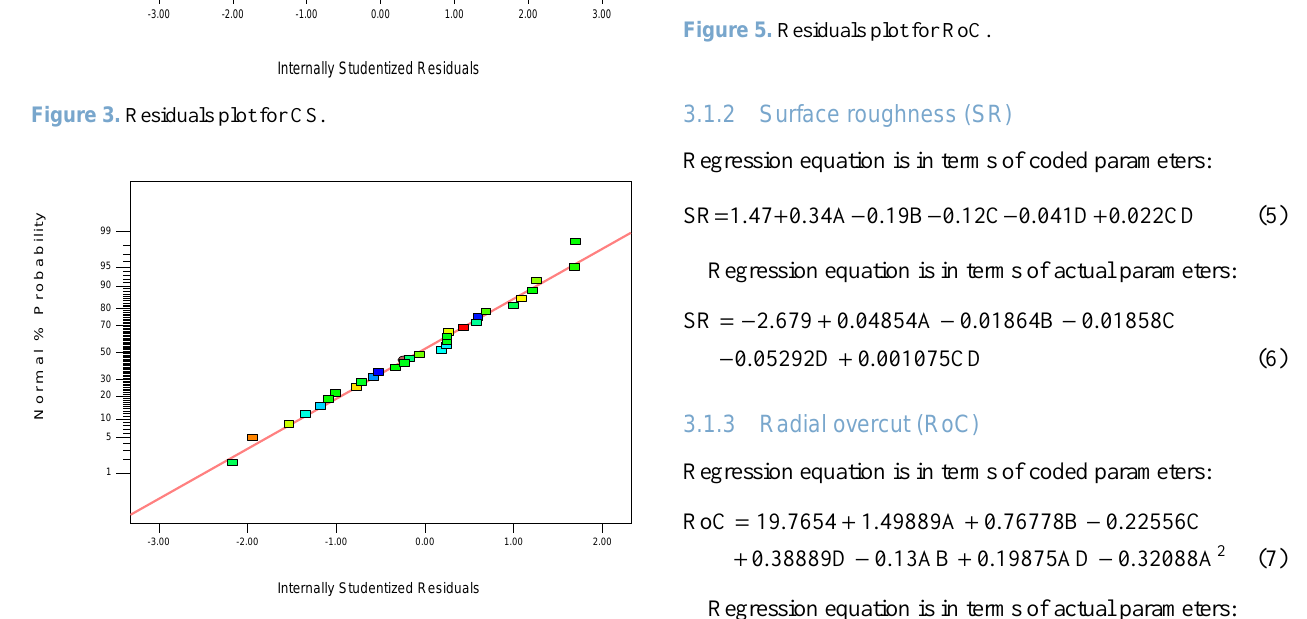
Figure 4. Residuals plot for SR. Figure 4 Residuals plot for SR Figure 4 Residuals plot for SR